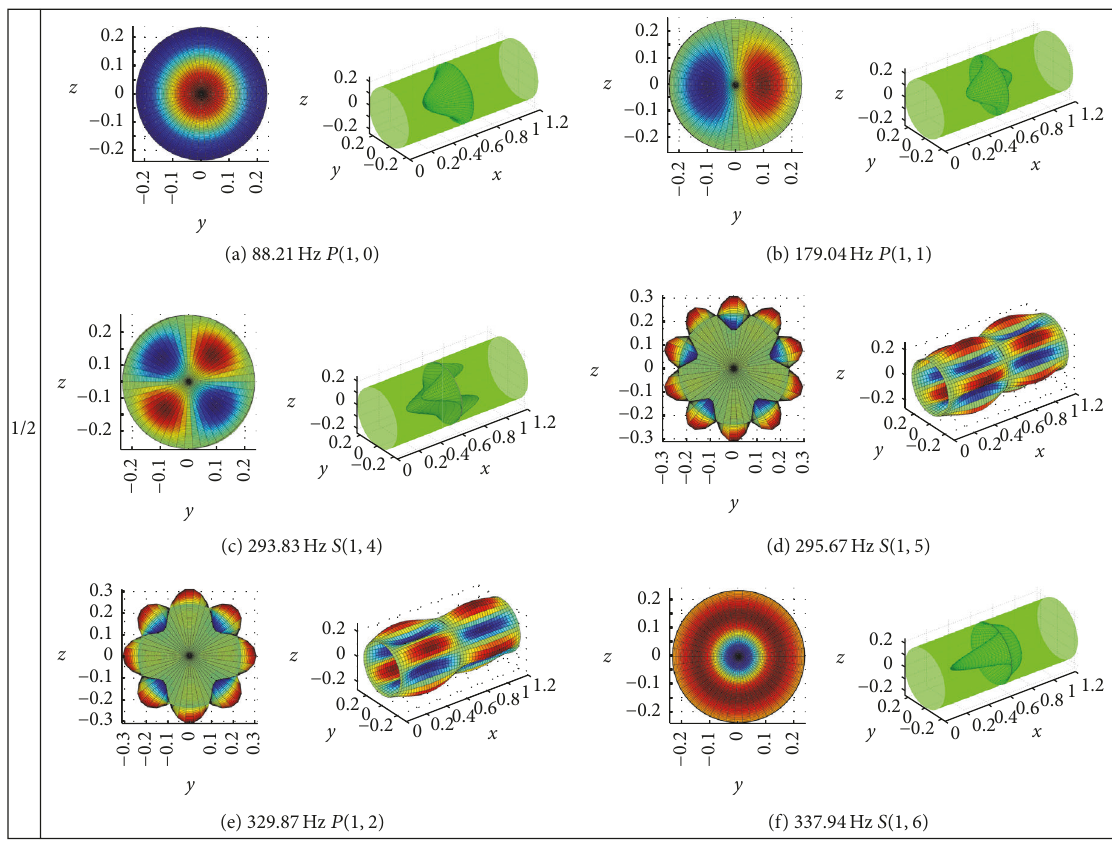
Figure 8: The modes of coupled structures with different coupling-junction positions.